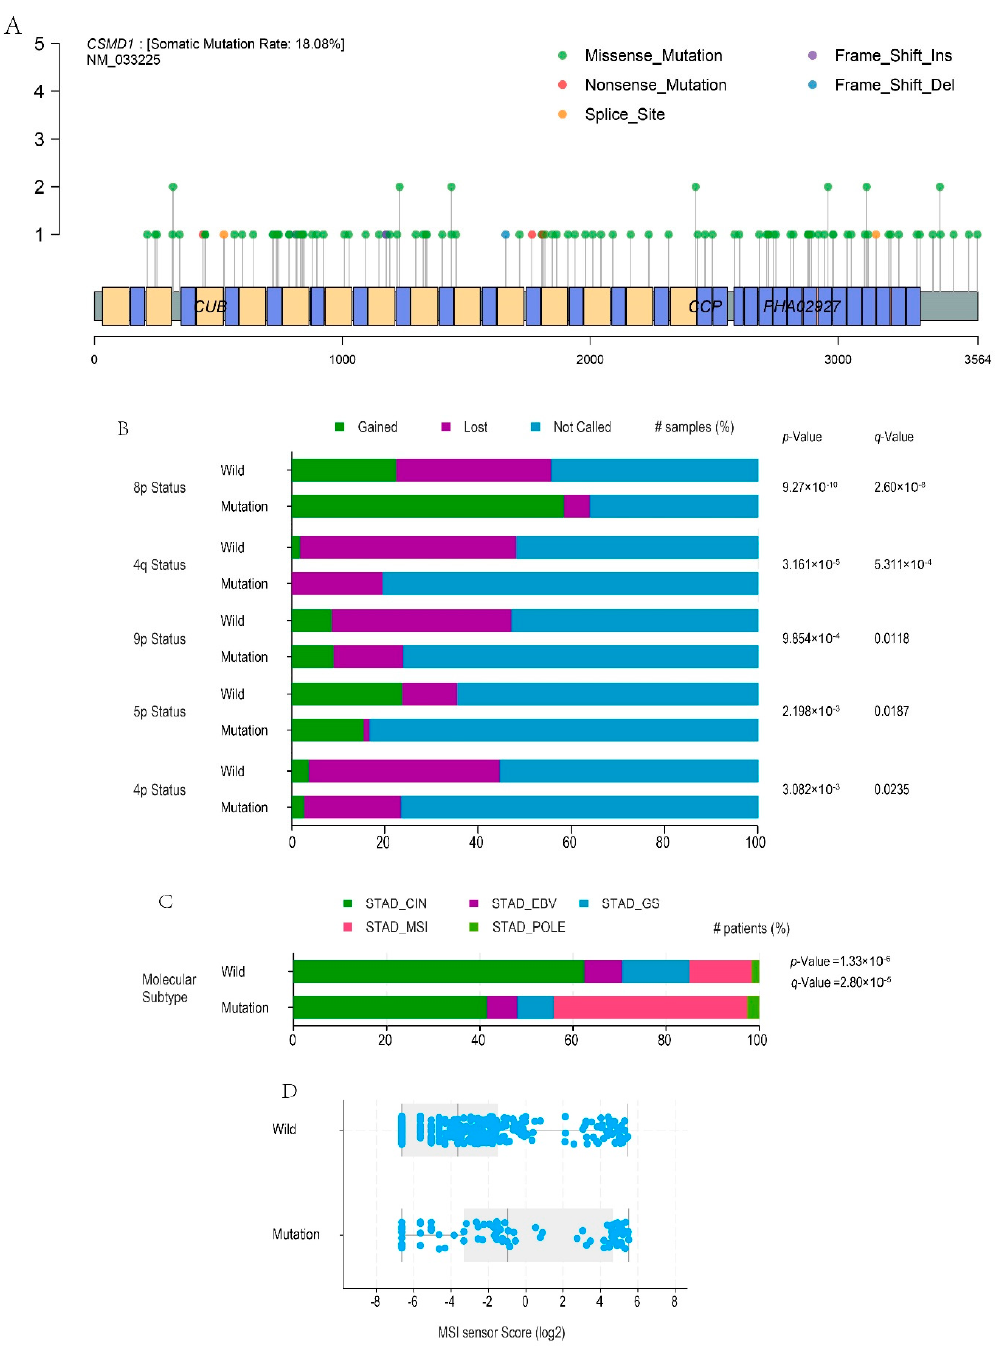
Figure 3. CSMD1 -mut profile and biogenetic alterations (( B – D ) were from yjr cBioportal website). ( A ) The location, type, and number of CSMD1 -mut and their relationship with known domains. Blue indicates the CCP domain, and yellow indicates the CUB do- main. The number of mutations is on the left, and the types of mutations are at the bottom. CSMD1 contains four members of the PHA02927 super family, also known as the secreted complement binding protein, which is composed of multiple CCP conservative domains in series. ( B ) The statuses of chromosomes 8p, 4q, 9p, 5p, and 4p in the chi-squared test: green for gained, purple for lost, and blue for not called. ( C ) Molecular subtype analyses in the chi-squared test. ( D ) MSI status in the Wilcoxon test.